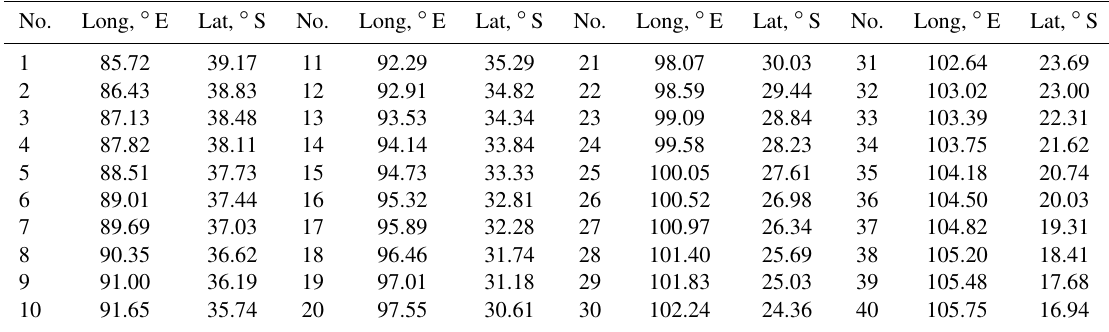
Table 1. Longitudes and latitudes of the origins preselected for screening